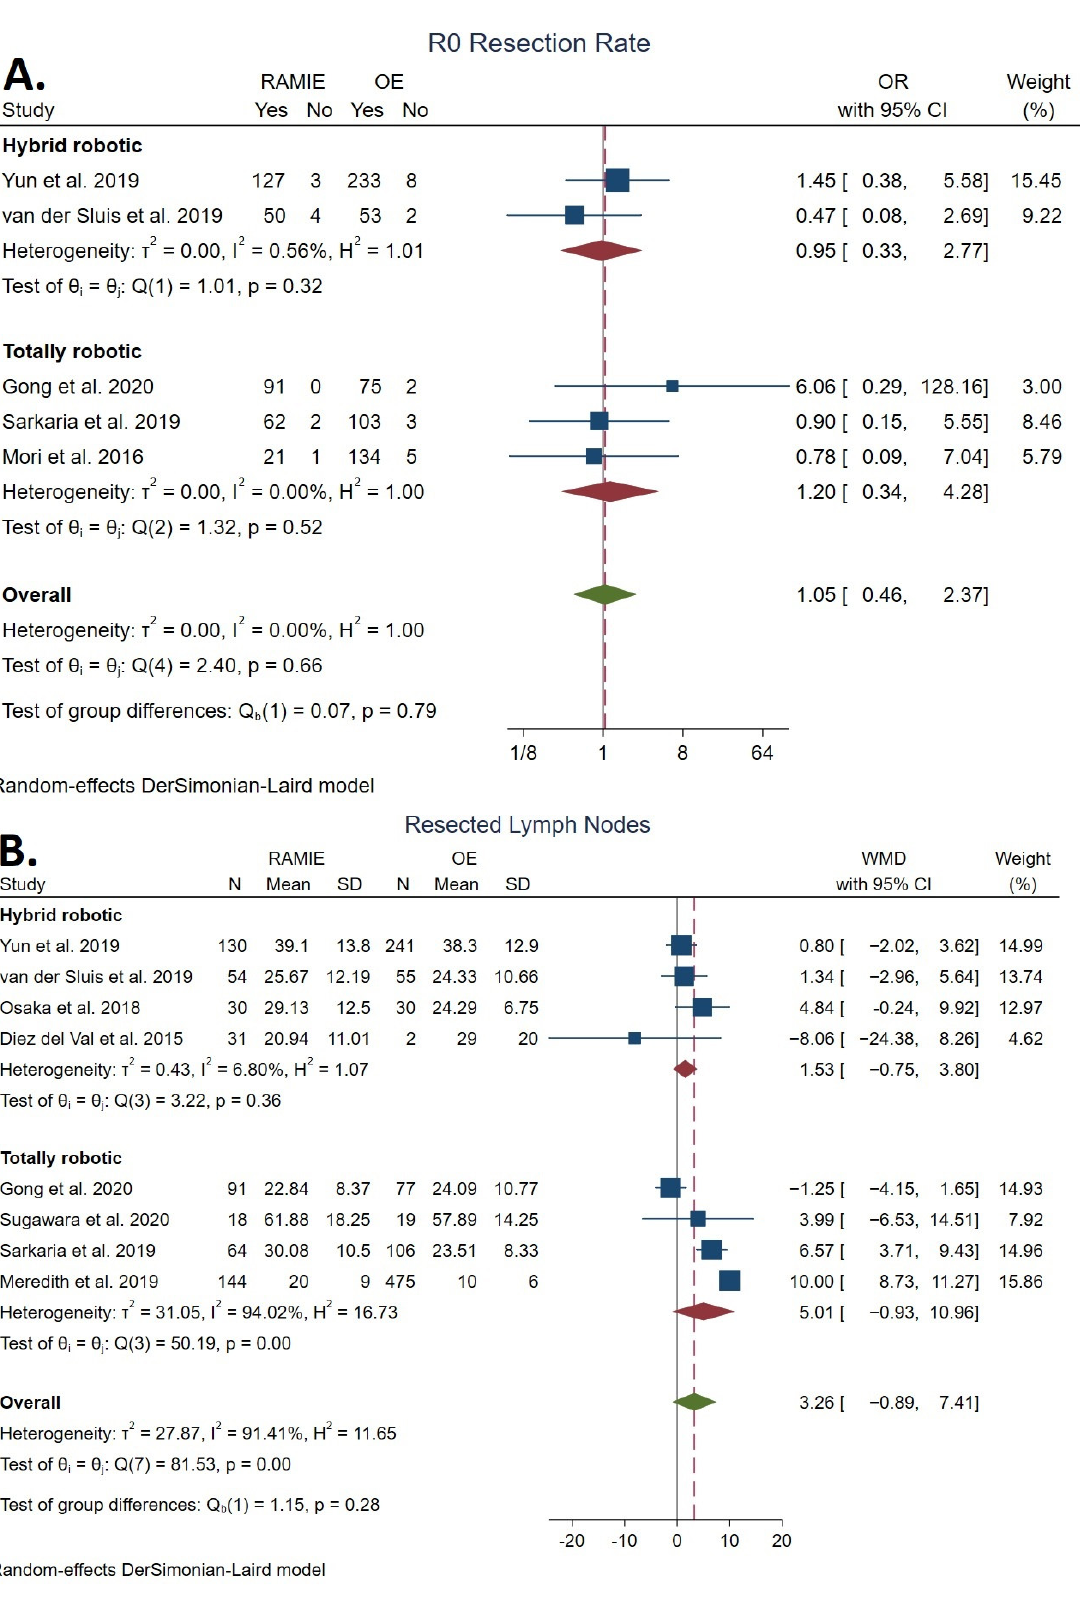
Figure 3. Forest plots of total lymph nodes resected ( A ) and margin ‐ negative resection (R0) rate ( B ) [21,23,34,35,37–41].